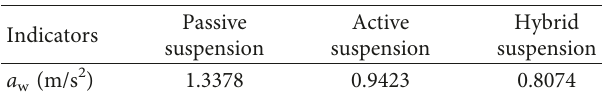
Figure 25: The power spectrum of the sprung mass acceleration of the hybrid suspension in active mode. Table 6: The sprung mass acceleration RMS of the hybrid sus- pension in active mode.